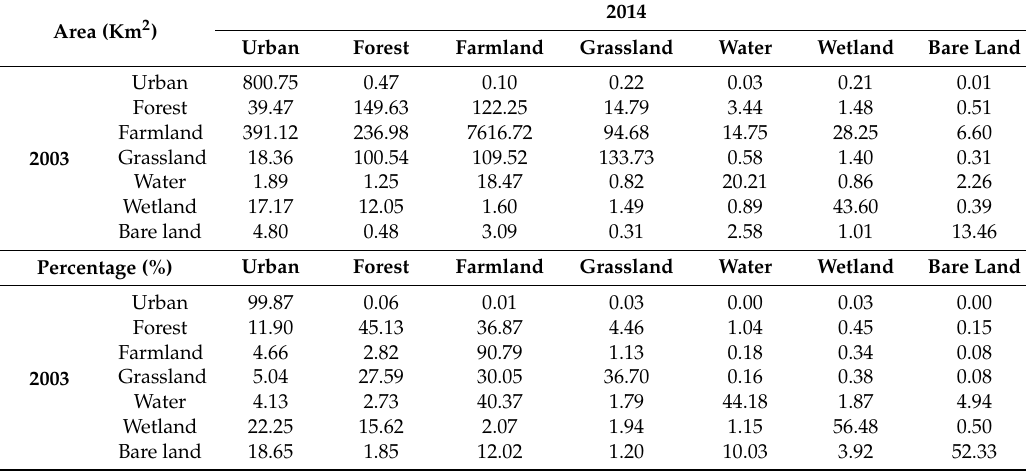
Table 4. Transition matrix of LULC area (km 2 ) and percentage (%) between 2003 and 2014. Area (Km 2